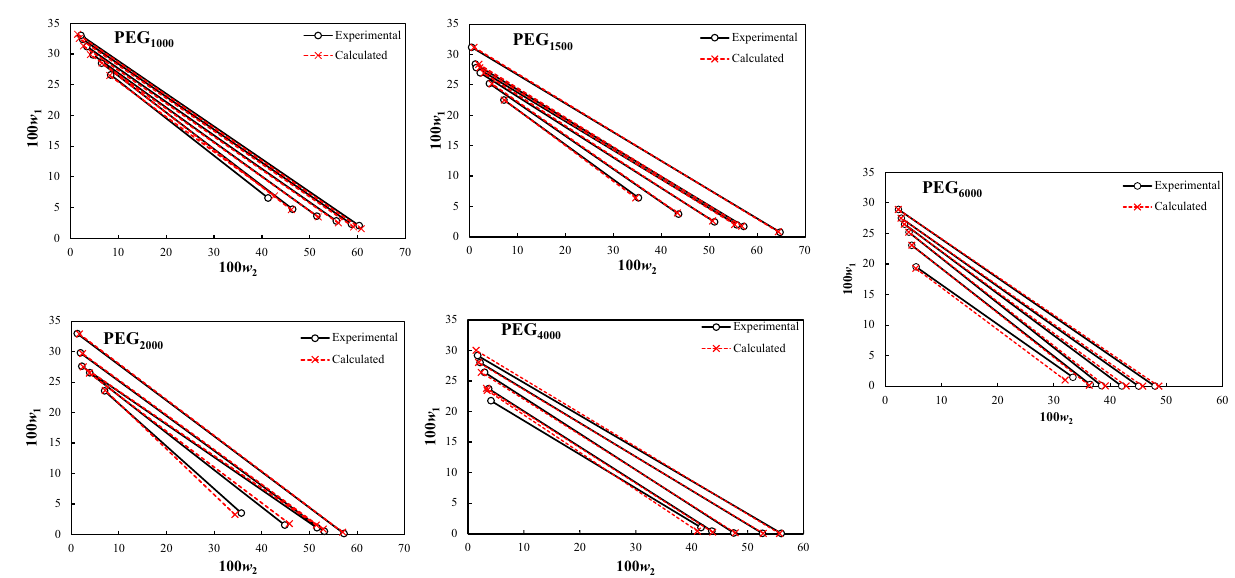
Experimental Calculated